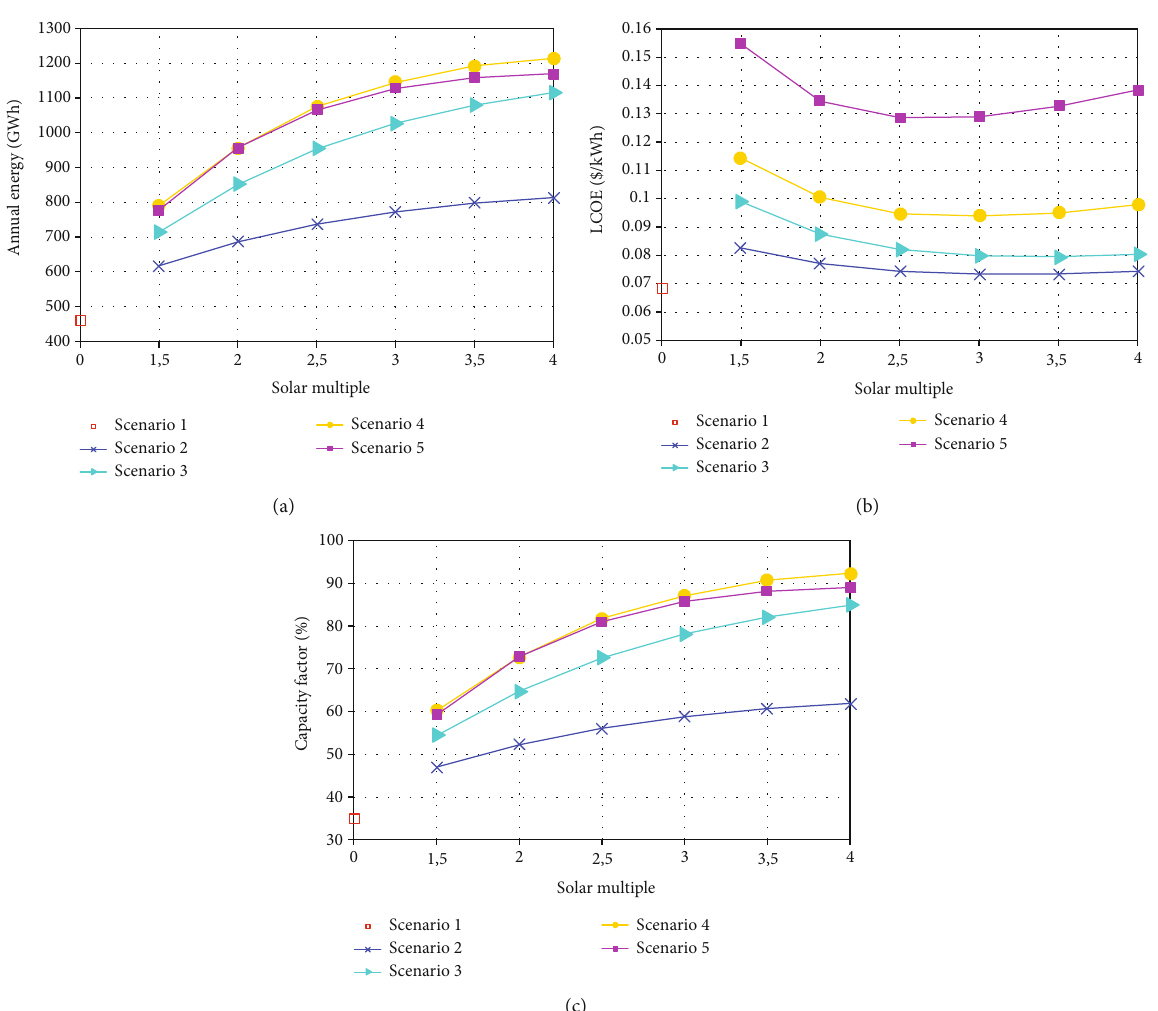
Figure 11: The variation of (a) annual energy, (b) LCOE, and (c) capacity factor according to solar multiple for TES = 14 h